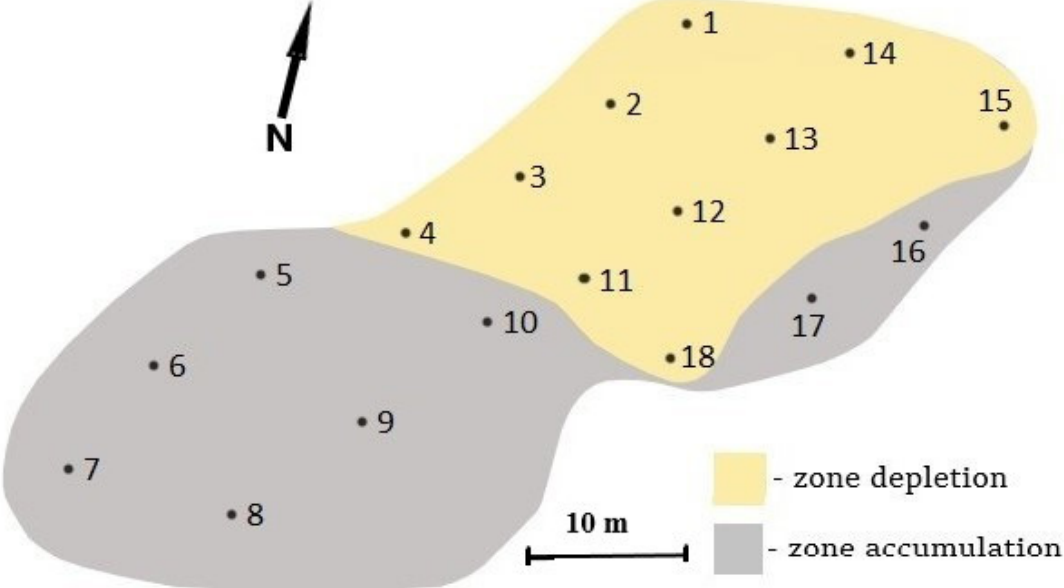
Figure 1. Soil sampling scheme on the landslide area.